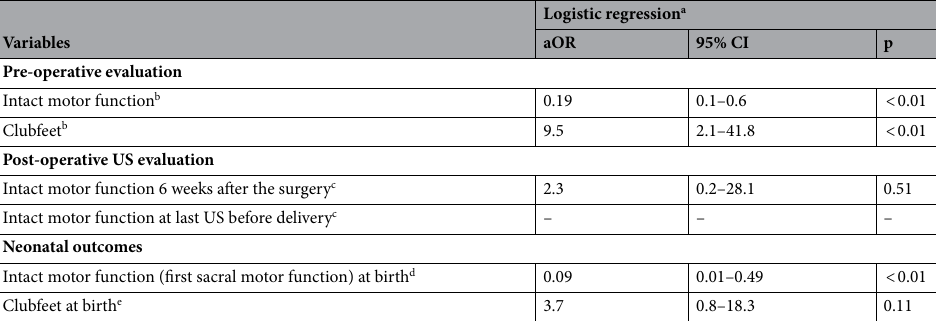
Table 2. Predictors for neurosurgical and neonatal characteristics in cases of large myelomeningocele. Large lesion was defined when volume was > 2.7 cc. aOR, adjusted odds-ration, CI, confidence interval, CSF, cerebrospinal fluid. a Represents the predictive value of large NTD for neurosurgical, post-operative and neonatal outcomes. b Adjusted on high anatomical level of lesion. c Adjusted on the type of repair (fetoscopic or open-hysterotomy), high anatomical level of lesion, learning curve (First 12 cases were considered as learning curve in both types of repair) and intact motor function at referral. d Adjusted on the type of repair (fetoscopic or open-hysterotomy), high anatomical level of lesion, learning curve (first 12 cases were considered as learning curve in both types of repair), gestational age at delivery and intact motor function at referral. e Adjusted on the type of repair (fetoscopic or open-hysterotomy), high anatomical level of lesion, learning curve (first 12 cases were considered as learning curve in both types of repair), gestational age at delivery and presence of clubfeet at referral.